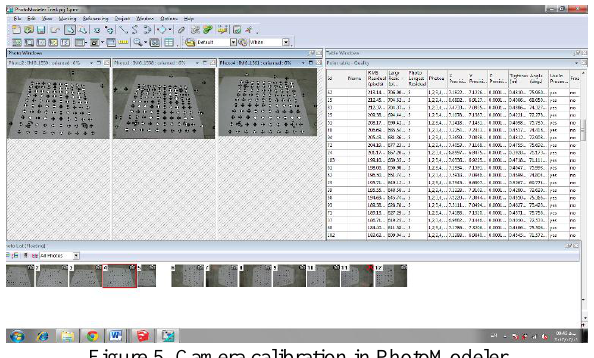
Figure 5. Camera calibration in PhotoModeler